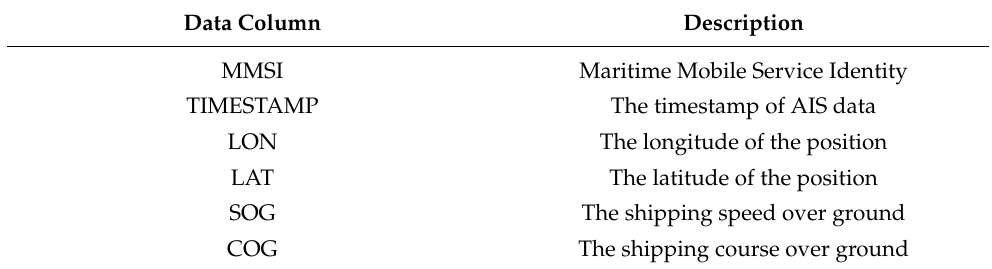
Figure 1. Schematic diagram of ship trajectory. Table 1. Description of parameters for dimensional data.